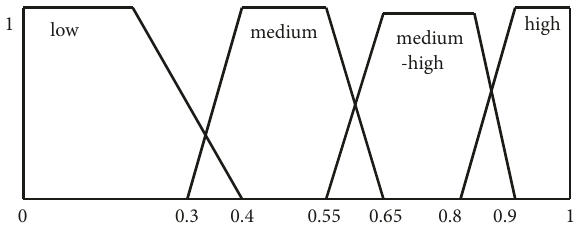
Figure 2: Membership function of fuzzy similarity